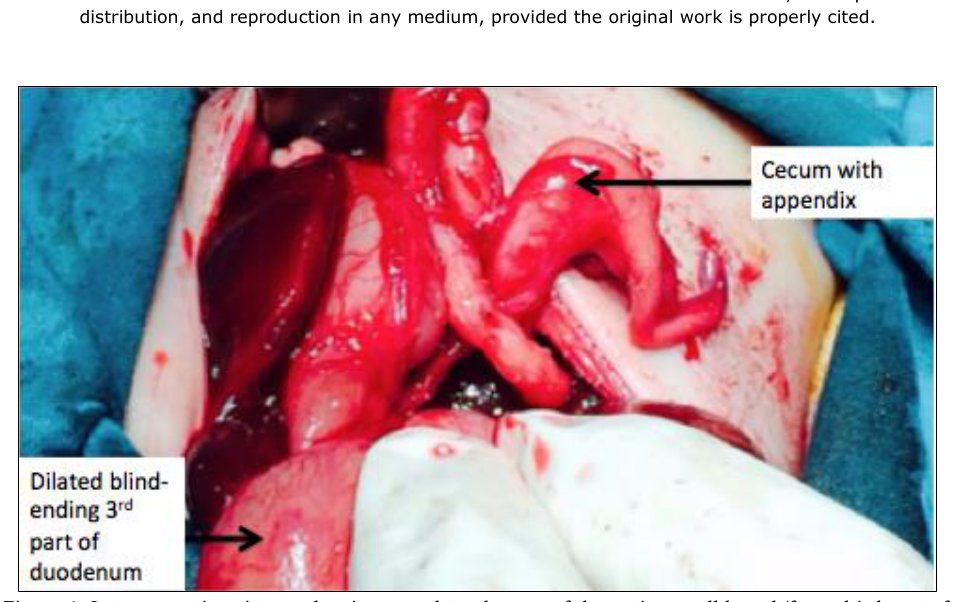
Figure 1: Intra-operative picture showing complete absence of the entire small bowel (from third part of duodenum to cecum) and its